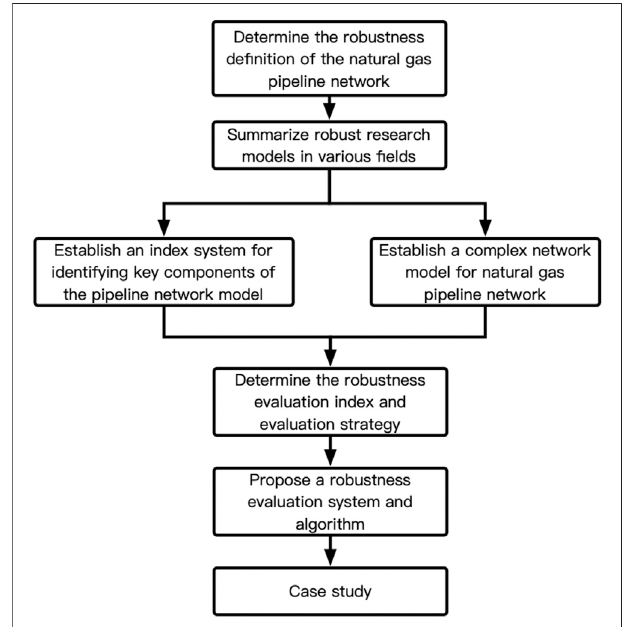
FIGURE 1 | The research framework of natural gas pipeline network ’ s robustness evaluation